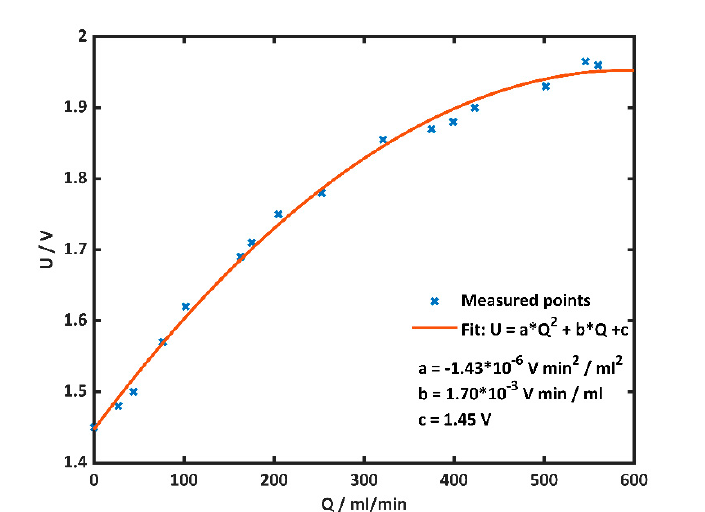
Figure 6. Voltage applied to the heating resistor to keep the NTC resistance at 22 k Ω for different flow rates. The sample temperature and the ambient temperature were 26.0°C. The parameters of the quadratic polynomial fit are given below the